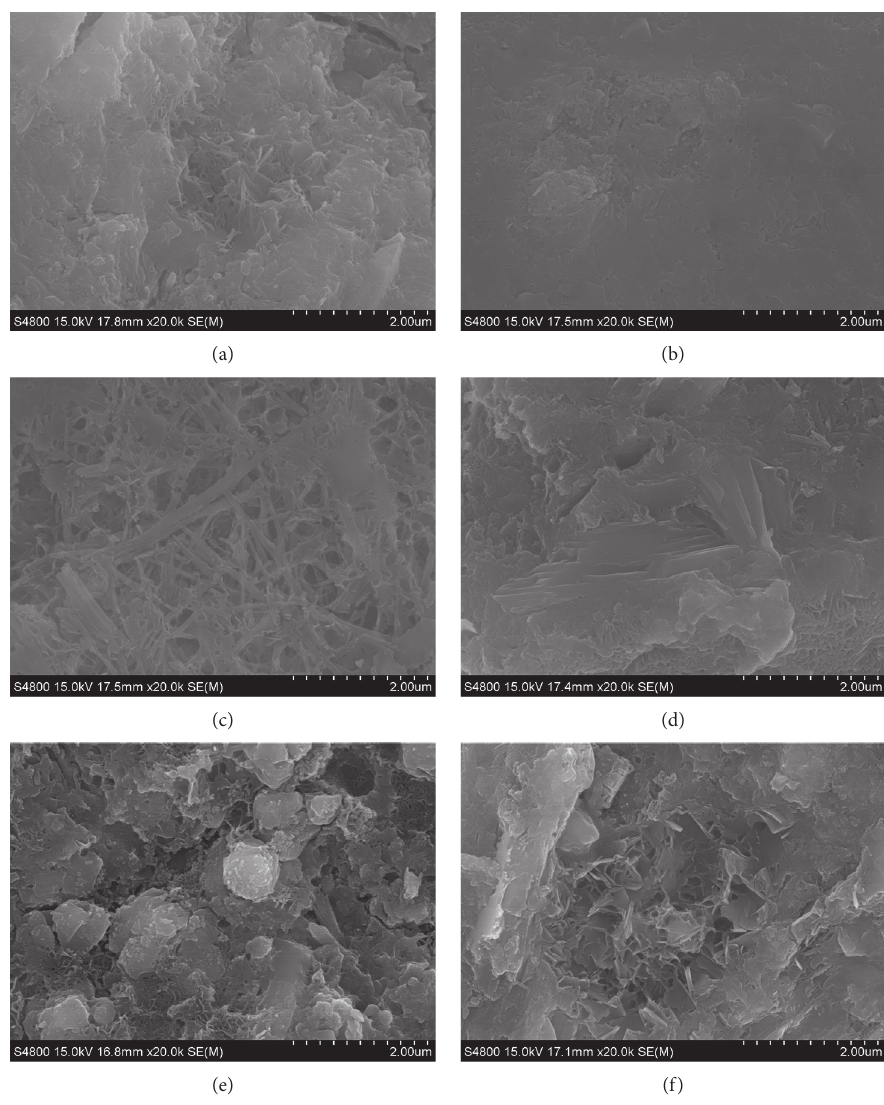
Figure 11: Microstructures of GO concrete before and after different salt-frost cycles. (a) GO0 after 0 salt-freezing cycles (b) GO3 after 0 salt-freezing cycles. (c) GO0 after 100 salt-freezing cycles. (d) GO3 after 100 salt-freezing cycles. (e) GO0 after 200 salt-freezing cycles. (f) GO3 after 200 salt-freezing